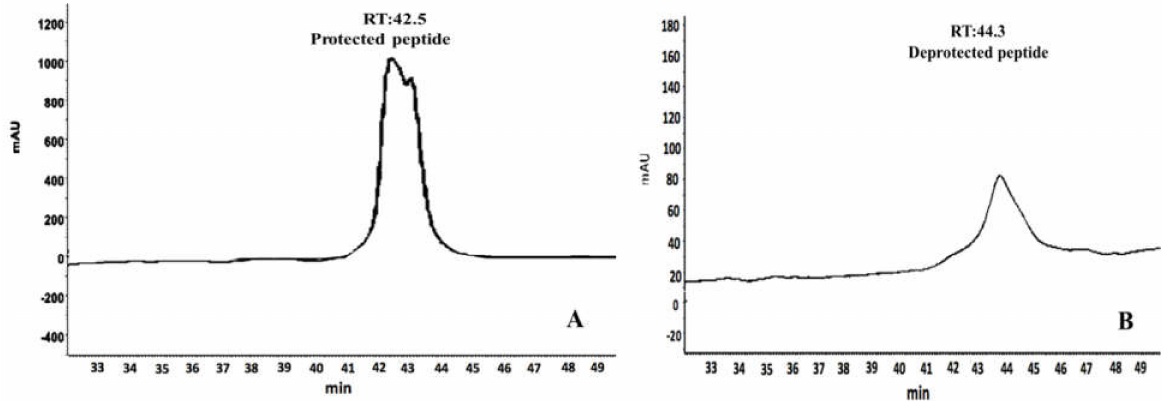
Figure 5. Comparison of the retention time between deprotected and protected in RP-HPLC. ACM protected ( A ) and deprotected ( B ). The retention time after deprotection shifted 1.8 min to the